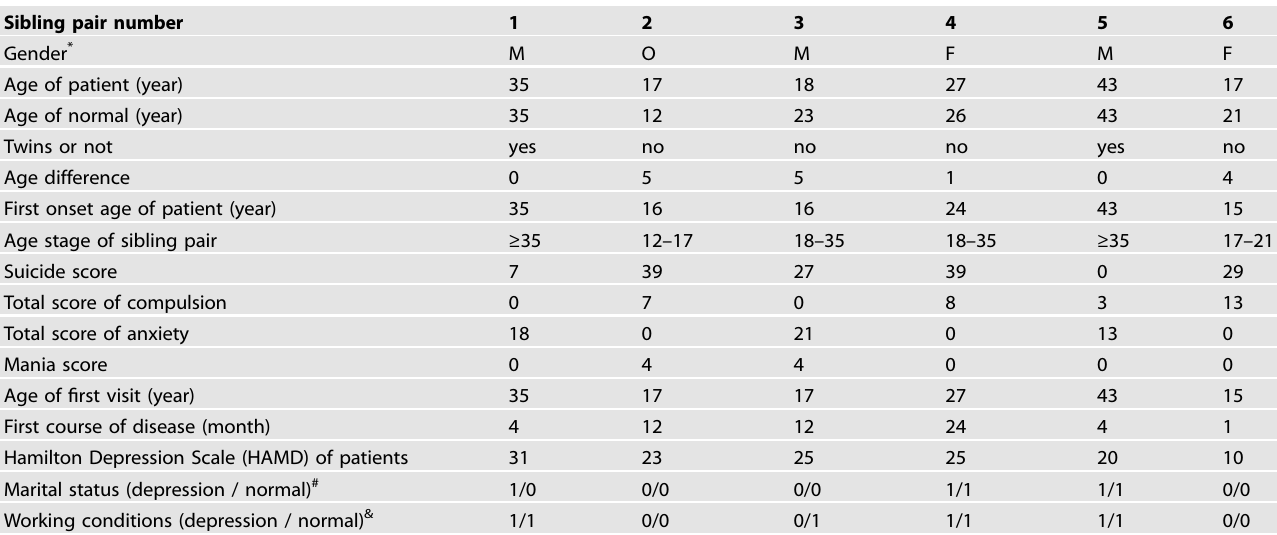
Table 1. Clinical characteristics of